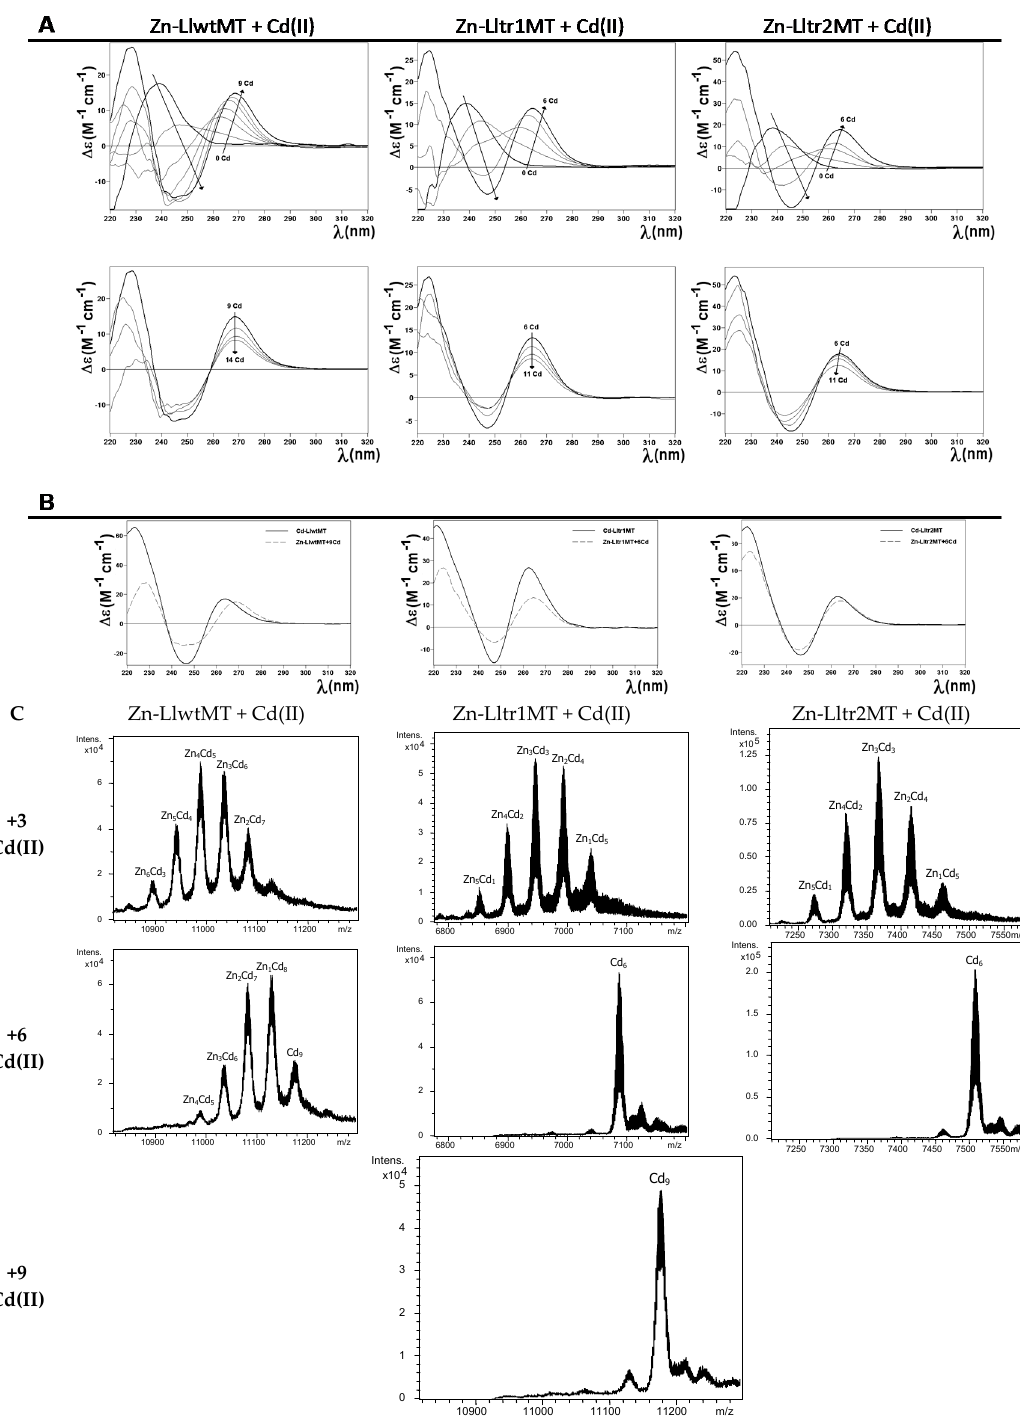
Figure 5. Zn(II)/Cd(II) replacement reaction on the Zn 9 -LlwtMT, Zn 6 -Lltr1MT, and Zn 6 -Lltr2MT complexes. ( A ) CD spectra of a 10 μ M solution of the Zn-LlMT samples, titrated with CdCl 2 at neutral pH up to 14 (LlwtMT) or 11 (Lltr1MT and Lltr2MT) Cd(II) equivalents; ( B ) Comparison of the CD spectra of the three recombinant productions of Cd-LlMT with those obtained at the end of the in vitro metal displacement reactions; ( C ) Deconvoluted ESI-MS spectra recorded after the addition of 3, 6, and 9 equivalents of CdCl 2 to the recombinant Zn-LlMT preparations.